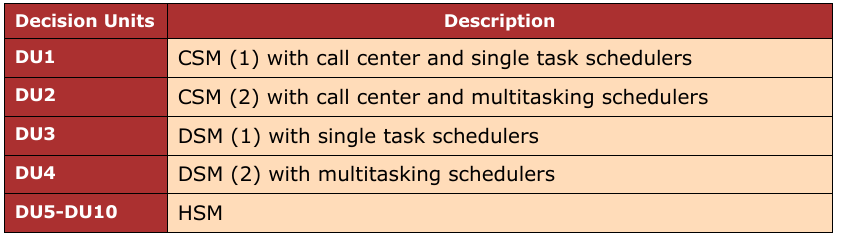
Table 2. Configuration generation for the major scheduling models.